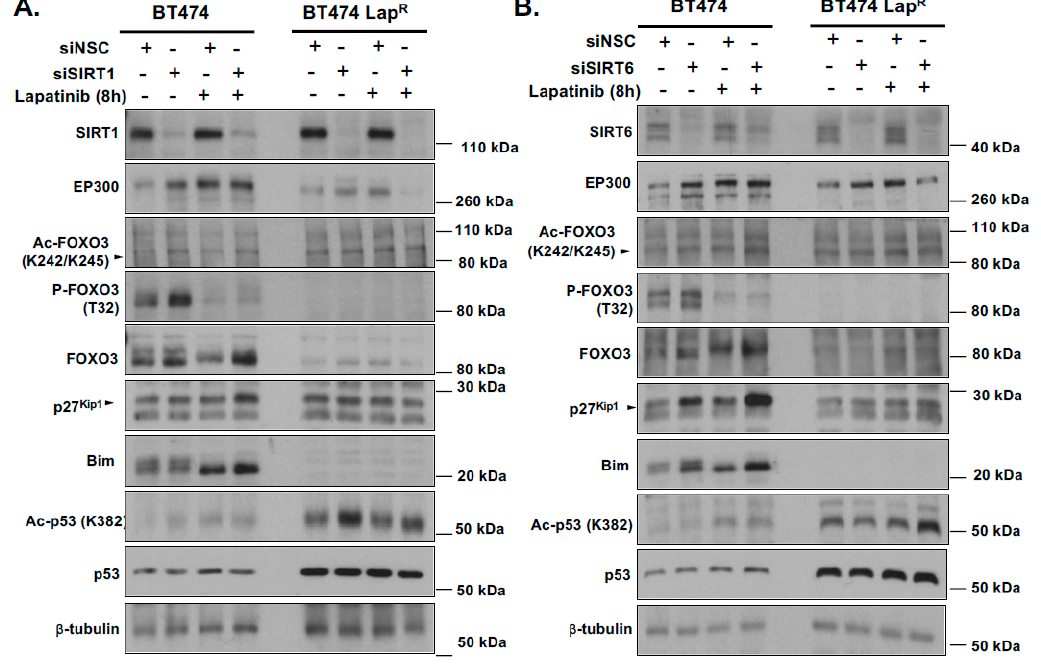
Figure 6. Silencing of SIRT1 and SIRT6 with or without Lapatinib treatment correlates with increased FOXO3 acetylation and its transcriptional activity. ( A , B ) BT474 and BT474 Lap R cells were transfected with Control (siNSC), siSIRT1 or siSIRT6 siRNAs and treated with or without 1 µM Lapatinib for 8 h. After harvesting, protein lysates were obtained and subsequent western blotting was performed to assess FOXO3 acetylation and its transcriptional activity using antibodies against Ac-FOXO3, FOXO3, p27 Kip1 , Bim and others as indicated. The β -tubulin was used as a loading control. ( C ) Co-